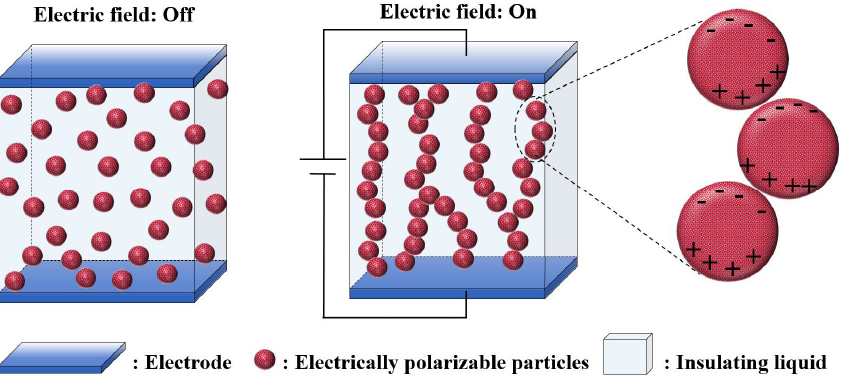
Figure 1. Schematic diagram of the electrorheological (ER) phenomenon under an applied electric